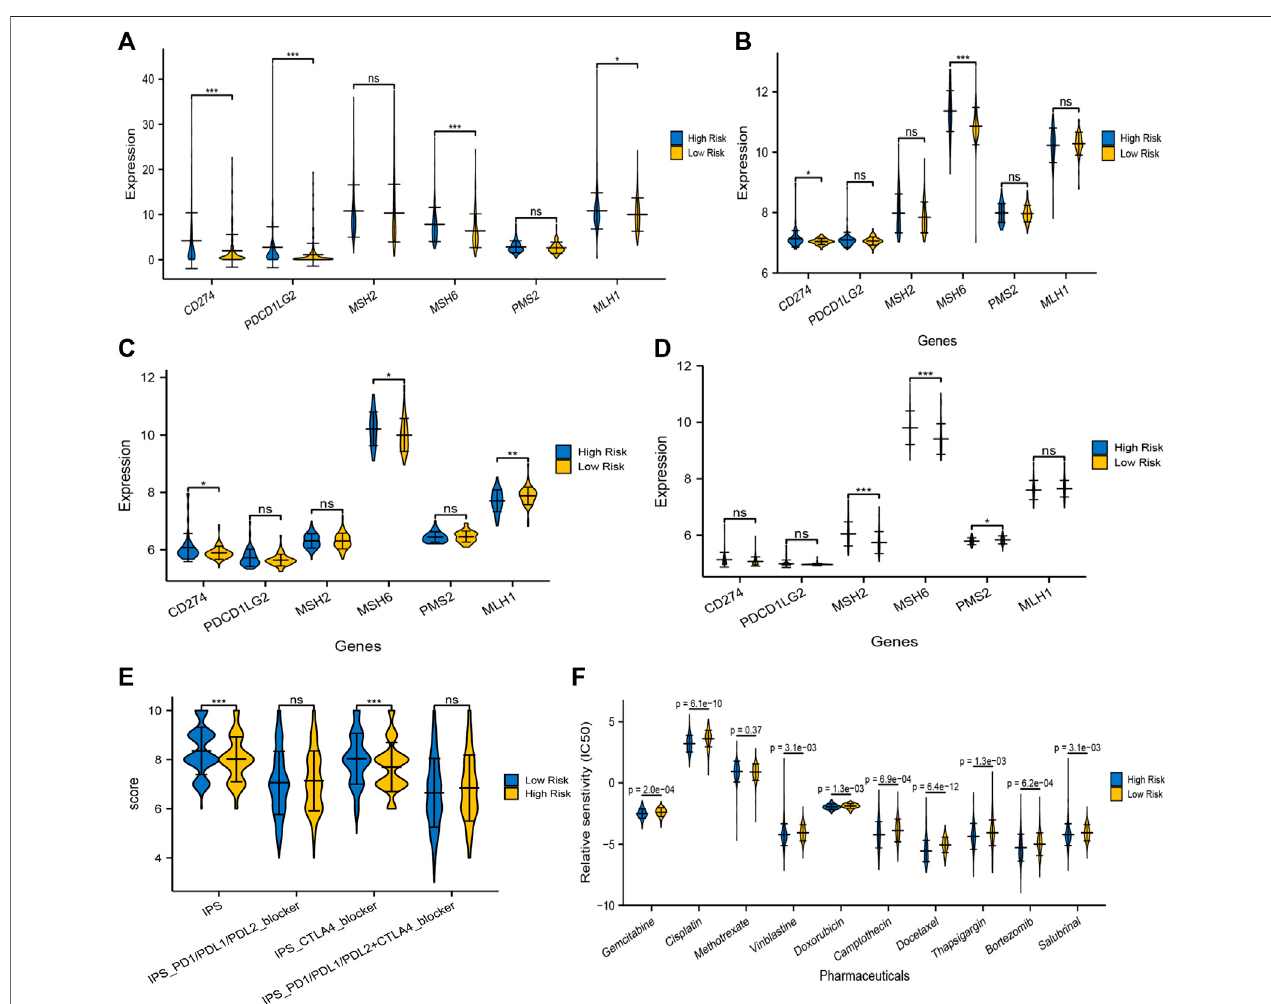
FIGURE 11 | Prediction of immunotherapy and chemotherapy response. The expressions of PD-L1 and/or PD-L2 were signi fi cantly higher in the high risk group compared with that in the low risk group in training and validation sets (A – D) . At least one of the four mismatch repair genes, MLH1, MSH2, MSH6, and PMS2, in tumor samples expressed signi fi cantly higher in the high-risk group, which signi fi ed that microsatellites might be more stable in the high risk group. (E) The overall IPS and IPS for CTLA-4 blocker in the high risk group was signi fi cantly lower than that in the low risk group, predicting that patients with higher risk scores had a worse immunotherapy response. (F) Moreover, IC50 of gemcitabine, cisplatin, vinblastine, doxorubicin, camptothecin, docetaxel, bortezomib, thapsigargin, and salubrinal in thehigh-riskgroupweresigni fi cantlylowerthanthatinthelowriskgroup,whichmeantthatapplicationofthesedrugscouldbemorebene fi cialtopatientswithhigherrisk